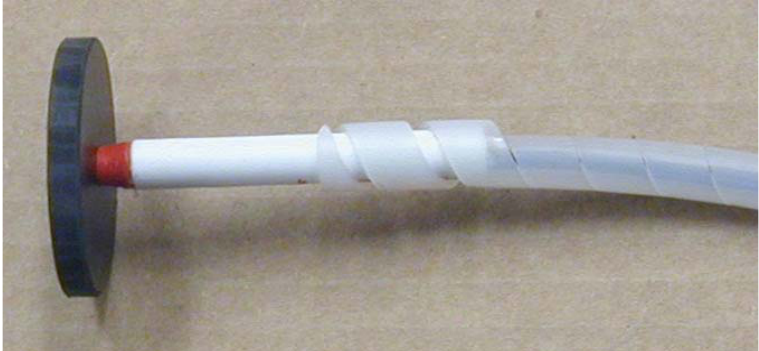
Figure 1. The pen assembly shown prior to securing with glue and enclosure in heat-shrink